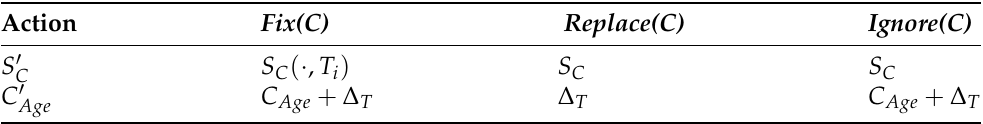
and C (cid:48) in the state reached after performing an action in a C Age